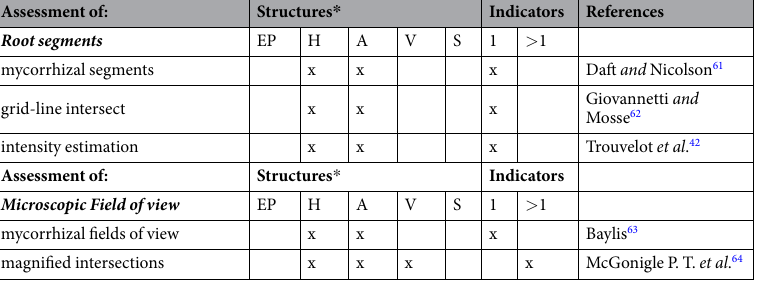
Table 1. Synthesis of AM microscopic evaluation methods. Note:structures specifically mentioned by authors in their methodology, where – EP = entry point, H = hyphae, A = arbuscules, V = vesicles, S =